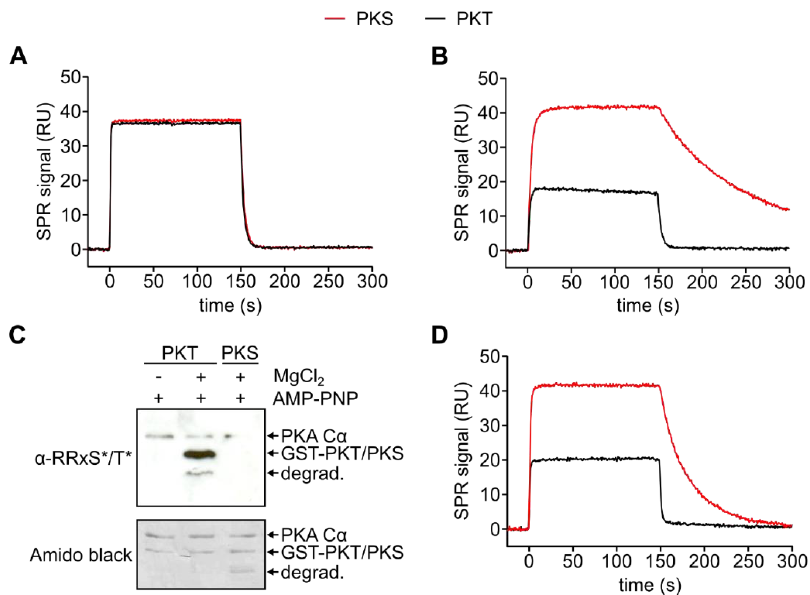
Figure 3. SPR analysis of the formation of the Michaelis complex. ( A ) Comparison of the interaction between PKA Cα (900 nM) and GST-PKS (red) and GST-PKT (black), respectively, in the absence of metal ions and nucleotides (Figure S4). Both binding kinetics are similar. ( B ) Comparison of the interaction of PKA Cα (100 nM) with GST-PKS (red) and GST-PKT (black), respectively, in the presence of 0.2 mM AMP-PNP and 1 mM MgCl 2 (Figure S5). The Michaelis complex with PKS is stabilized while in the case of PKT, the complex dissociates faster. ( C ) Western blot with a phospho-PKA substrate antibody (α-RRXS*/T*). Phosphorylation of GST-PKT by PKA Cα can be detected after 5 min incubation at 25 °C in the presence of 0.2 mM AMP-PNP and 1 mM MgCl 2 . ( D ) Interaction of 300 nM PKA Cα with GST-PKS (red) and GST-PKT (black) in the presence of 0.2 mM AMP-PCP and 1 mM MnCl 2 (Figure S6). The complex with PKS can be stabilized with Mn 2+ ions, while the PKT Michaelis complex dissociates